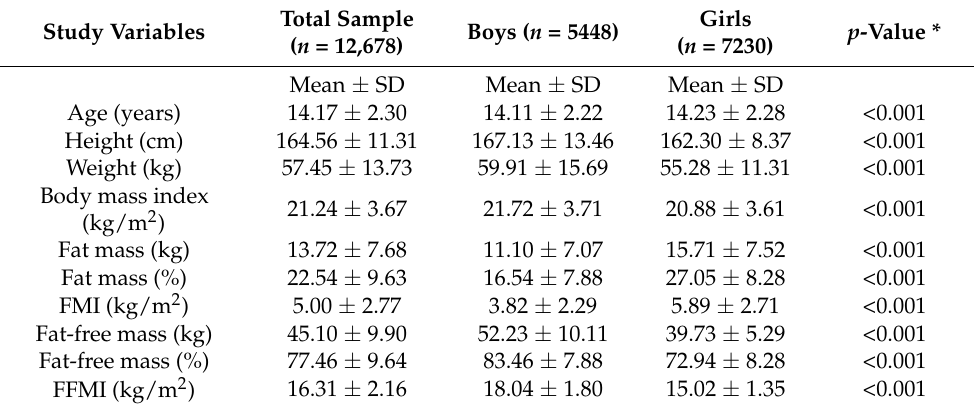
Table 1. Sex-specific descriptive statistics of the study participants ( n = 12,678).